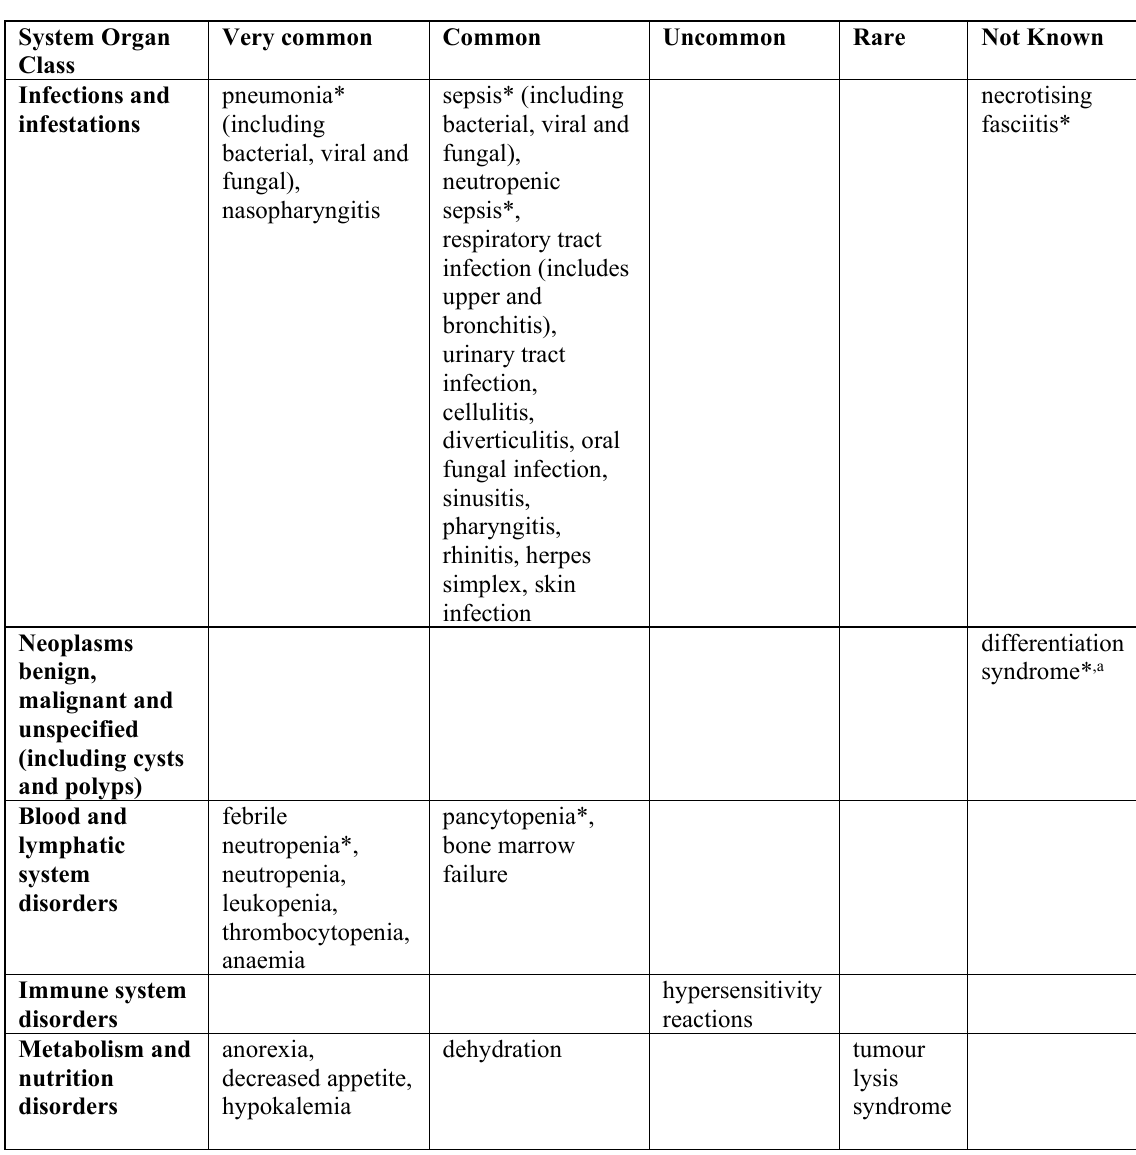
Adverse reactions reported in patients with MDS or AML treated with azacitidine (clinical studies and post-